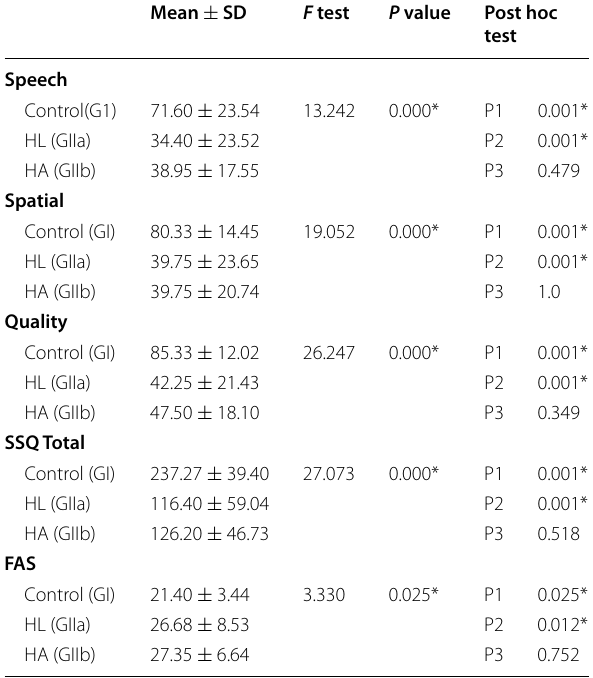
Table 1 ANOVA test for comparison of Speech, Spatial and Quality of Hearing Scale (SSQ) and Fatigue Assessment Scale (FAS) scores between the control group and study subgroups